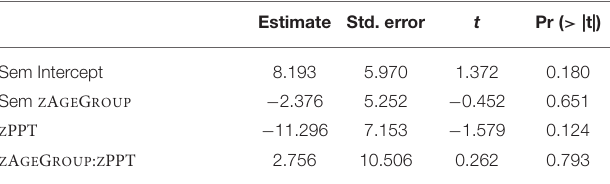
TABLE 8 | Lmer model for semantic priming with fixed effects of Z A GE G ROUP and Z PPT , as well as their interaction. Estimate Std.